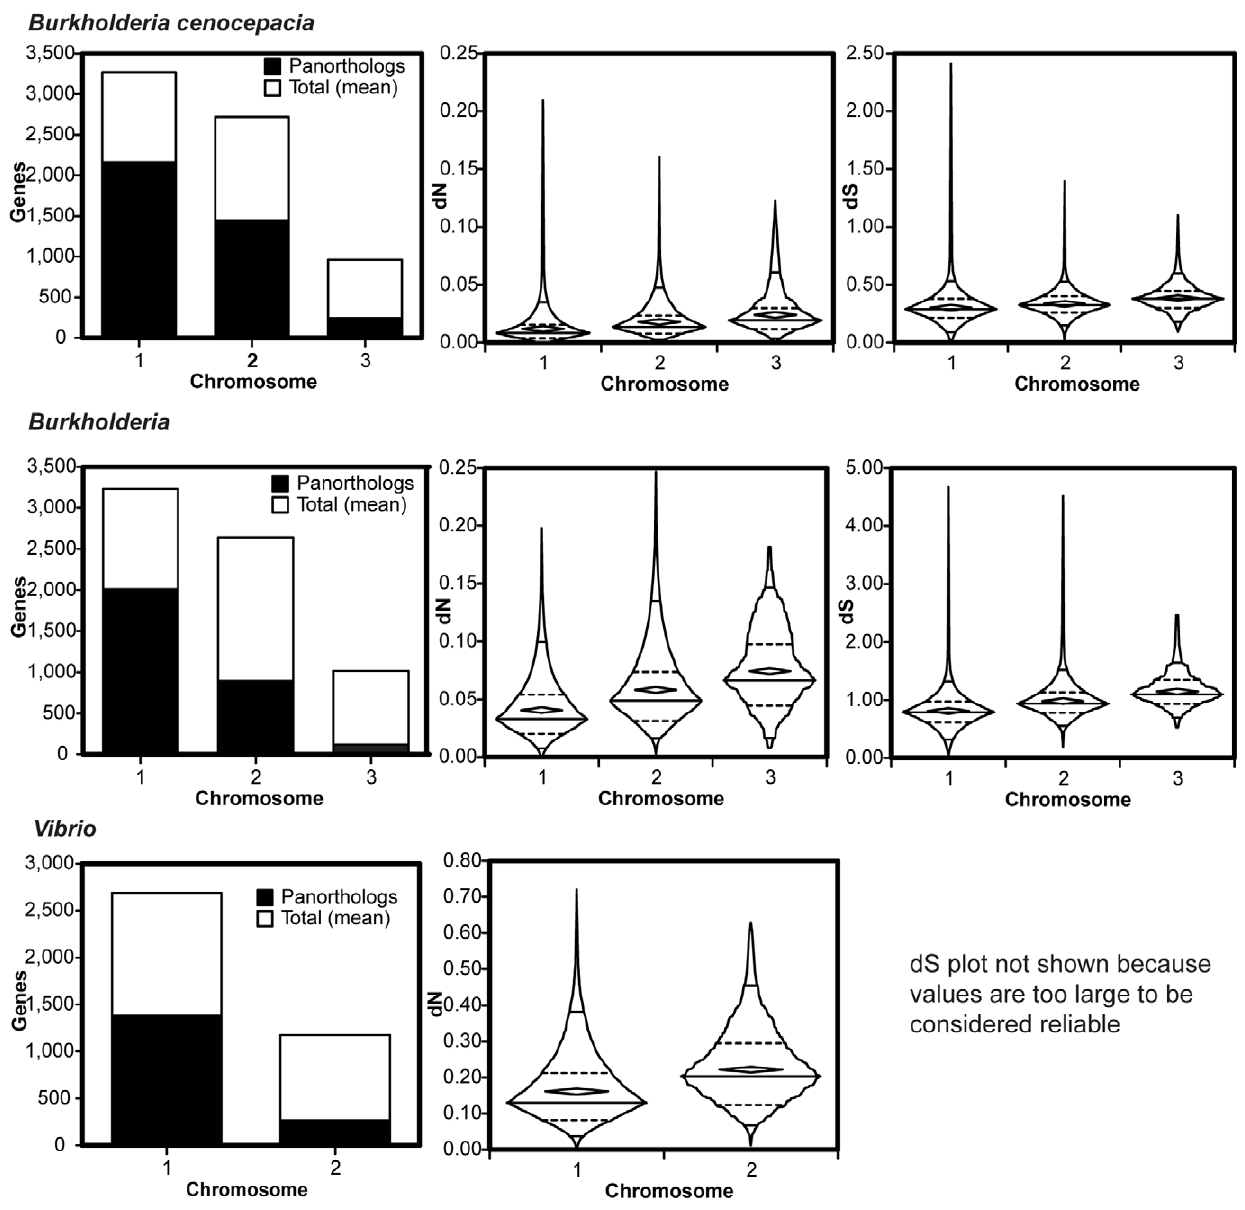
Figure 2. Distribution and evolutionary rates of orthologs vary by chromosome in three sets of bacterial genomes. Orthologs were identified in three different genome sets (Fig. 1, groups a-c) with B. cenocepacia , Burkholderia , and Vibrio . Column 1: orthologs are less abundant on secondary chromosomes, relative to mean genes/chromosome. Panortholog chromosome position was assigned based on the gene position in B. cenocepacia HI2424 for groups a and b and V. cholerae El Tor N16961 for group c. Columns 2 and 3: the rate of synonymous substitutions per synonymous site (dS) and the rate of nonsynonymous substitutions per nonsynonymous site (dN) among panortholog families both increase significantly on secondary chromosomes (statistical analyses in Tables S1-S3). Figures in columns 2 and 3 are boxplots in which horizontal lines indicate 95th, 75th, 50th, 25th, and 5th percentiles, from top to bottom, interior diamonds indicate the mean, and the exterior shapes represent the overall distribution of the rates on each chromosome.